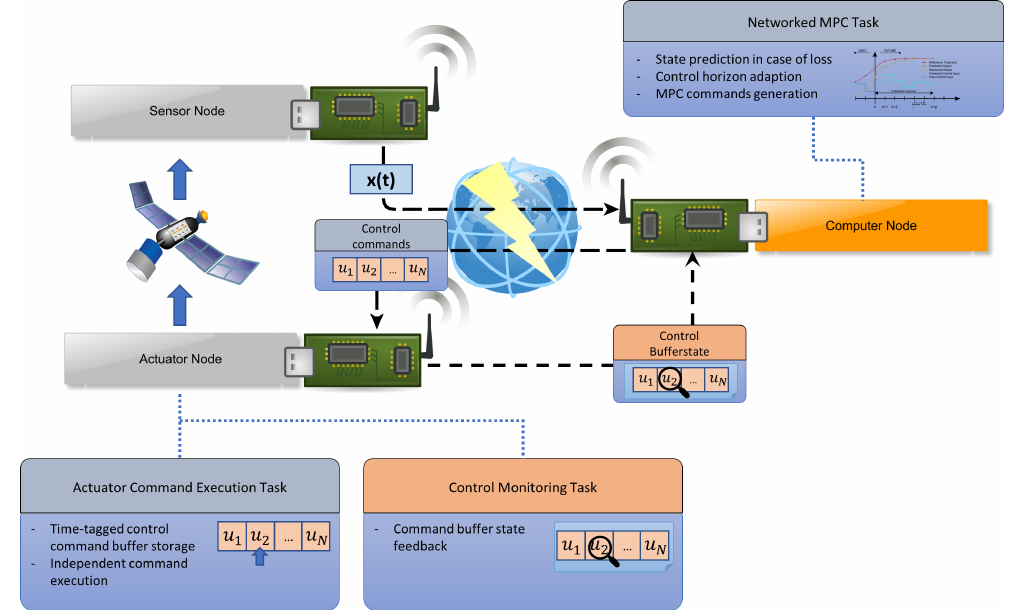
Figure 6. Diagram of the networked closed control loop with sensor-, actuator- and controller node. The necessary tasks running on each node and the corresponding exchanged data packets are also